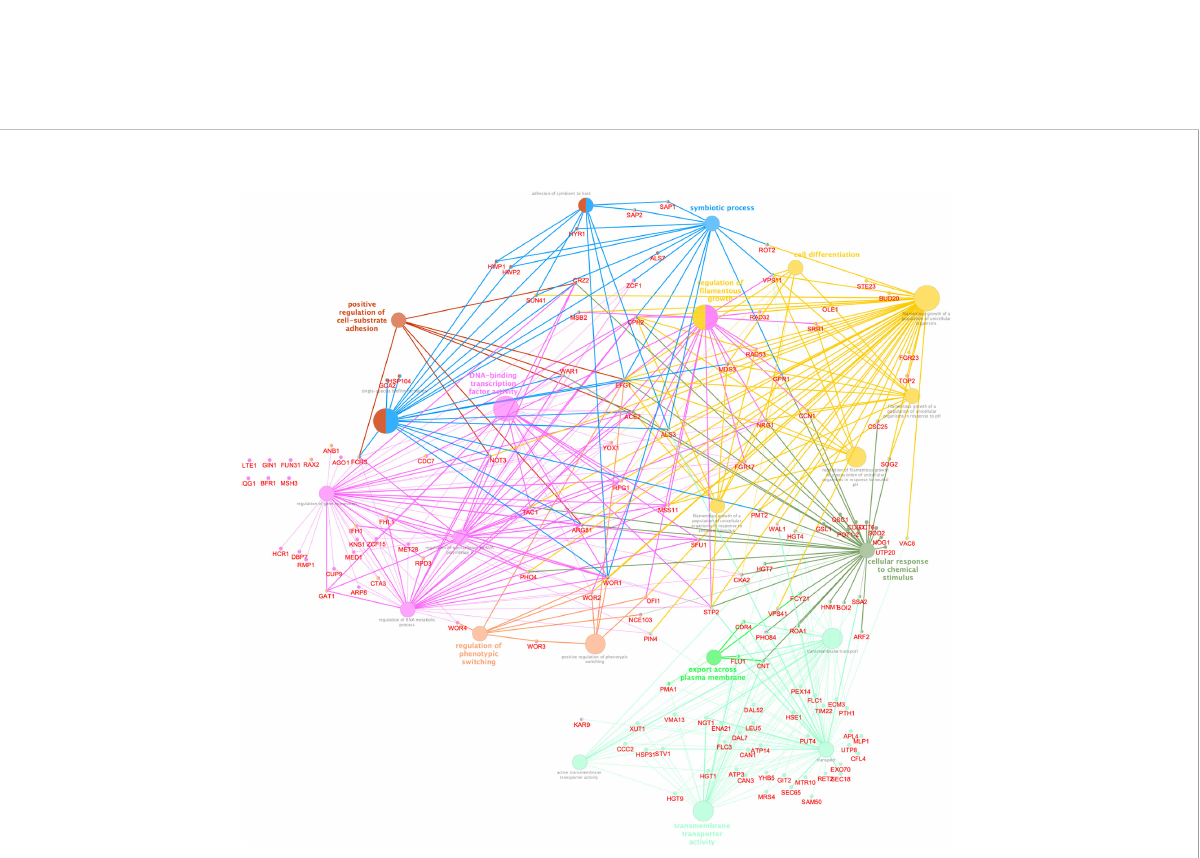
FIGURE 7 Cytoscape-based network analysis of 447 ChIP-enriched regions in CaNAM only. Biological process enrichment analysis using ClueGO and CluePedia Cytoscape plugins. The size of nodes indicated the degree of signi fi cance. The most signi fi cant term de fi ned the group name (Bonferroni adjusted pValue ≤